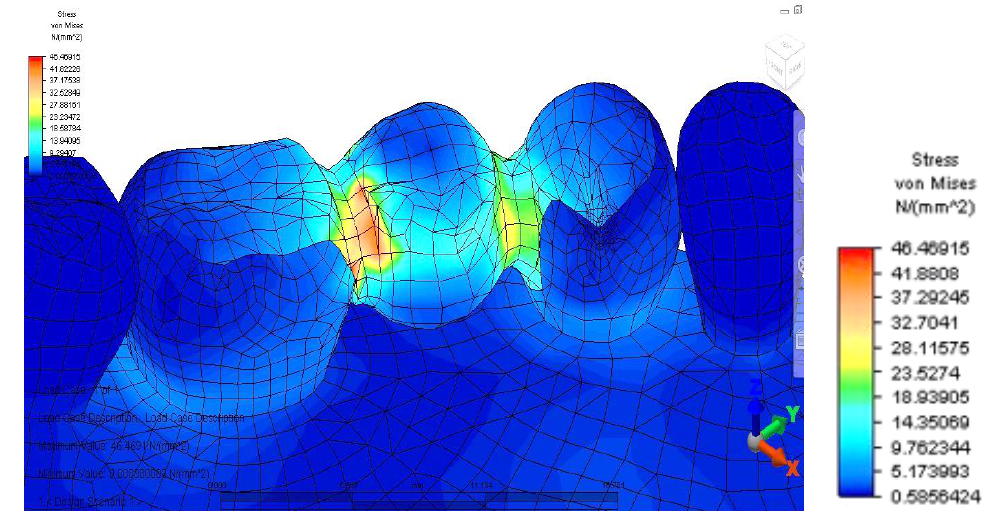
Figure 3. Tensions distribution at the bridge level, when the reaction force is placed in the 3.5